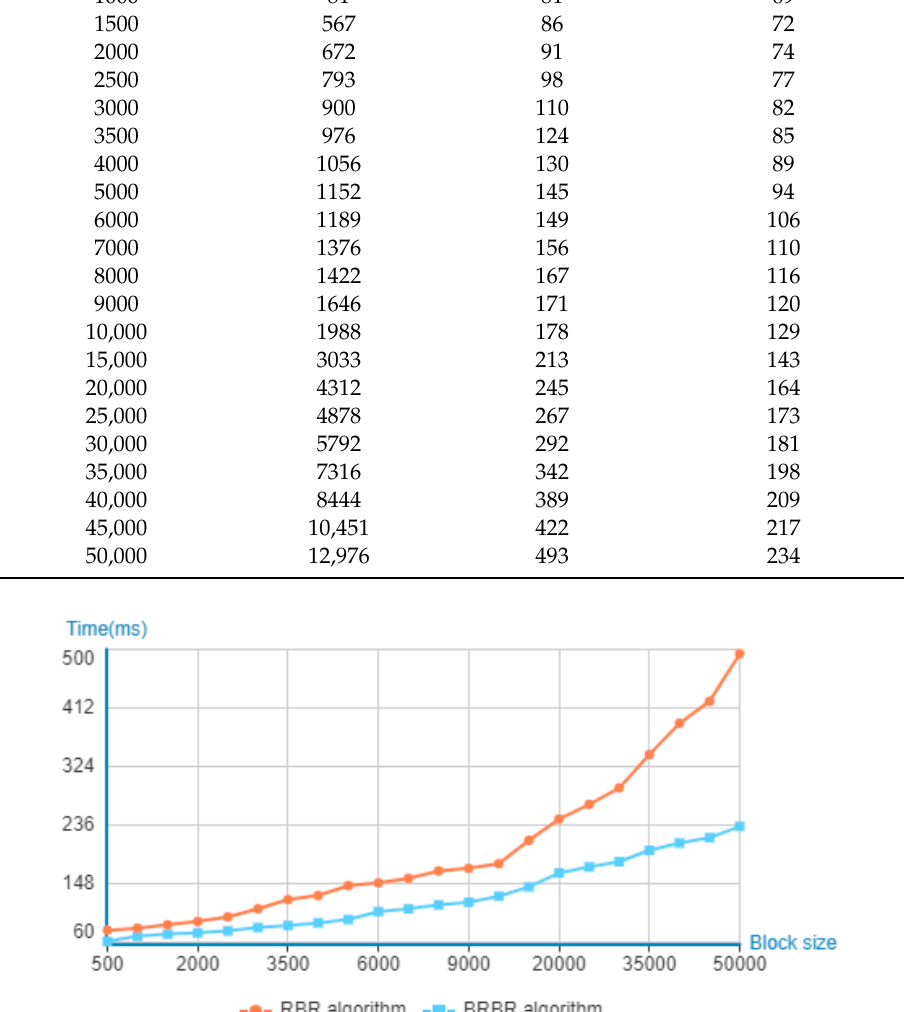
Table 4. Comparison of retrieval time under different user scale (unit: ms).